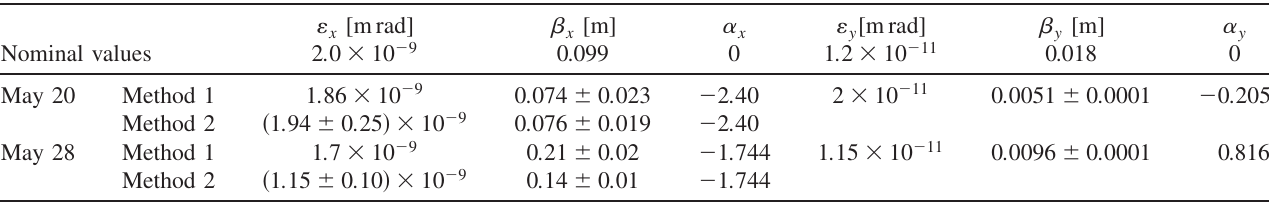
TABLE IV. Twiss parameters and horizontal emittance computed from post-IP wire scanner measurements, compared with nominal values. The listed uncertainties result from propagating the errors in Eq. (6), taking into account the measured beam size statistical fit errors in Table III, the measured dispersion errors and a 7% uncertainty from the finite wire size correction.